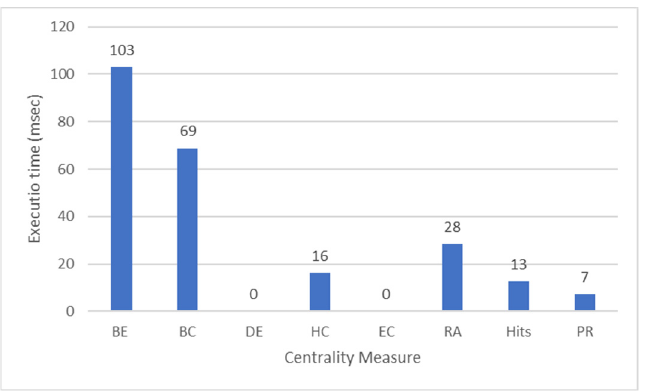
Figure 9. The average execution time for calculating the centrality measures on DBpedia v3.8 (ms).